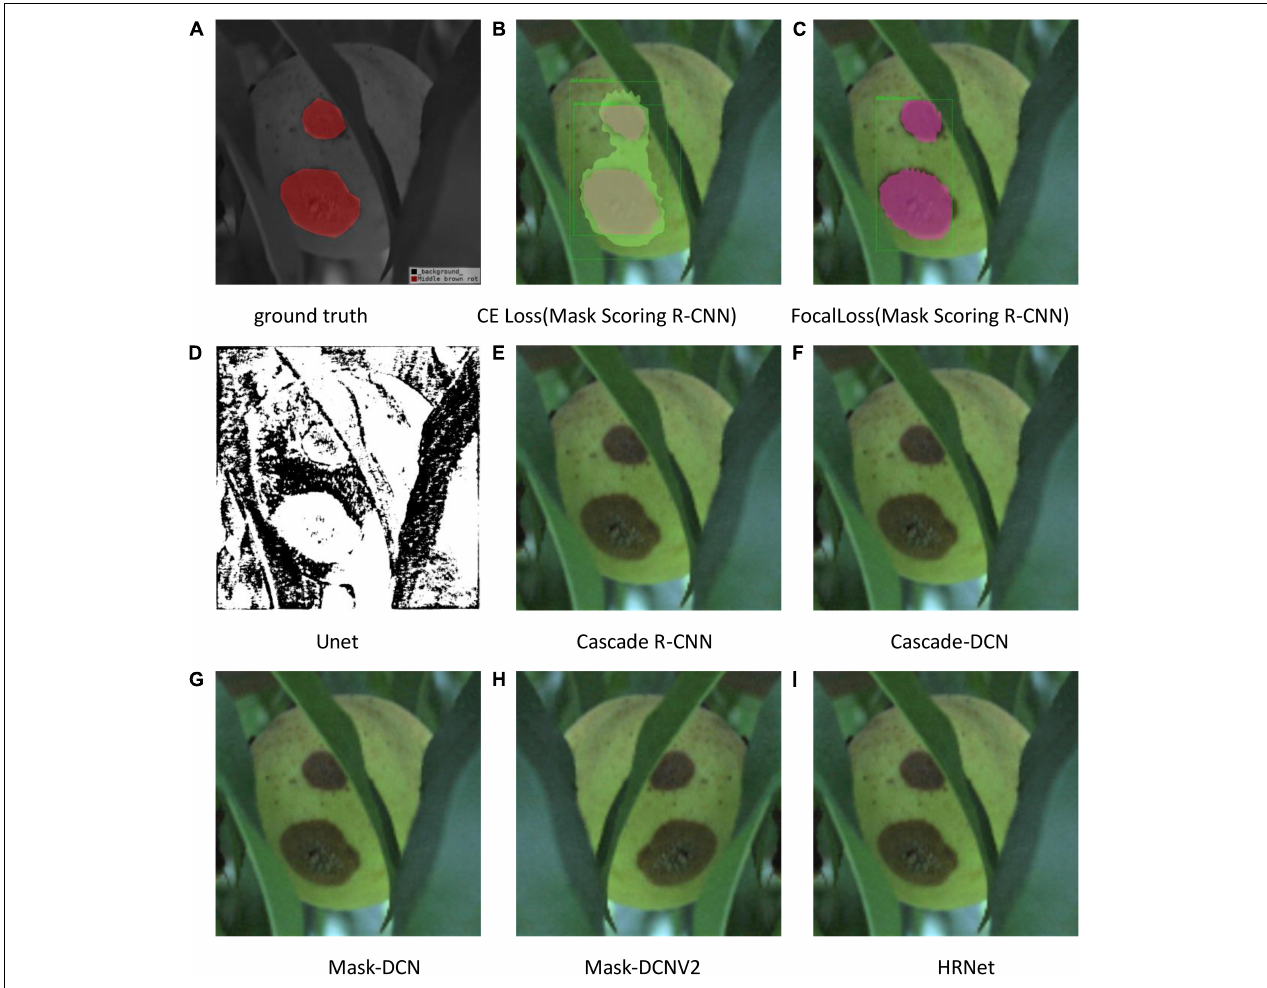
FIGURE 10 | Test results of different methods. (A) Ground truth, (B) CE Loss on Mask Scoring R-CNN, (C) Focal Loss on Mask Scoring R-CNN, (D) Unet, (E) Cascade R-CNN, (F) Cascade-DCN, (G) Mask-DCN, (H) Mask-DCNV2, and (I)